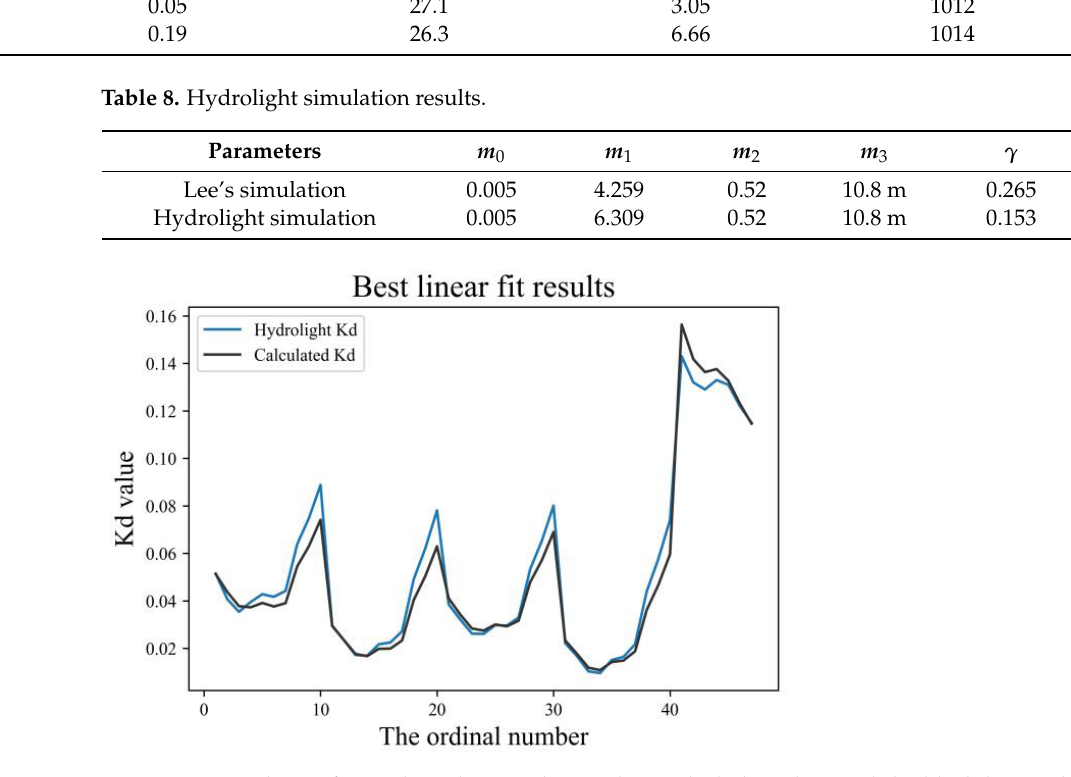
Figure 10. Best linear fit results. The grey line is the Hydrolight value, and the black line is the calculated value. The vertical axis is the Kd value, and the horizontal axis is the serial number of the fitted points.